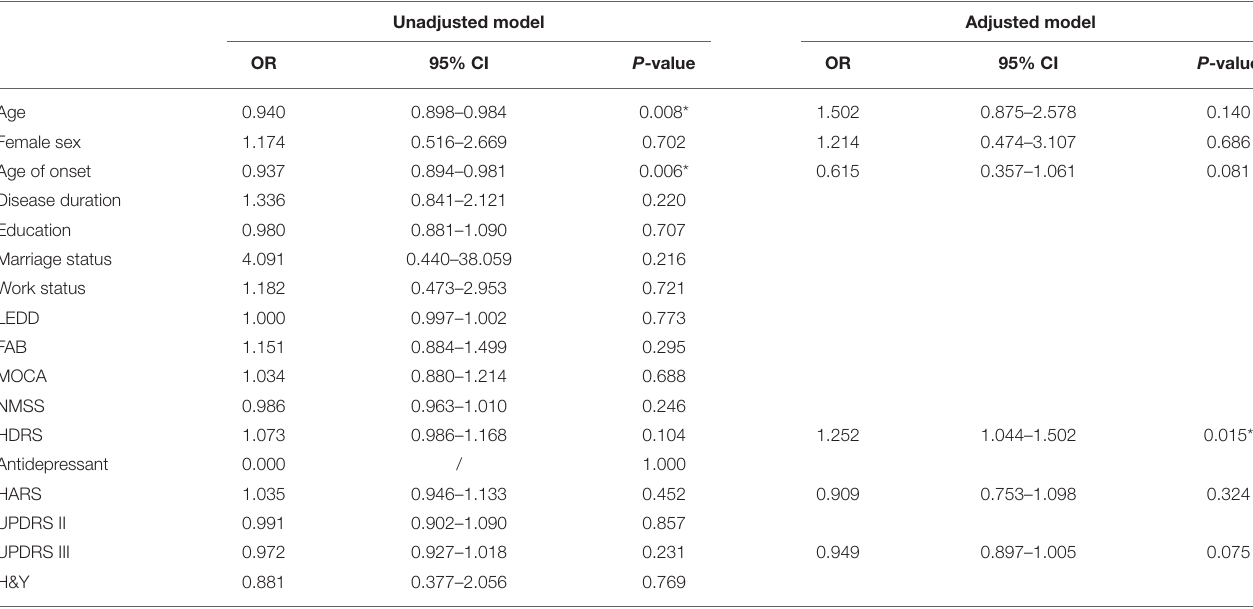
TABLE 3 | Predictive factors for the development of self-stigma in patients with PD ( n =